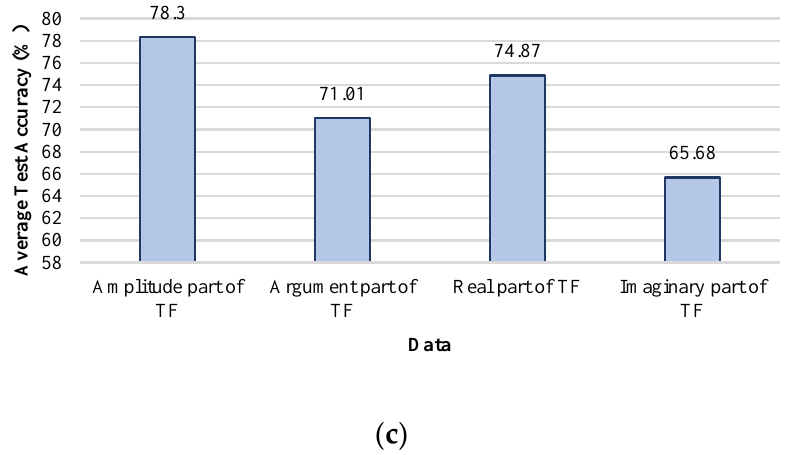
Figure 28. Average performance of models, using indices and parts of the TF in determining the severity of the DSV fault: ( a ) average performance of the GMDH and MLP models; ( b ) average per- formance when models are trained when the extracted features are from different indices; ( c ) average performance of models when the extracted features are from different parts of the TF.